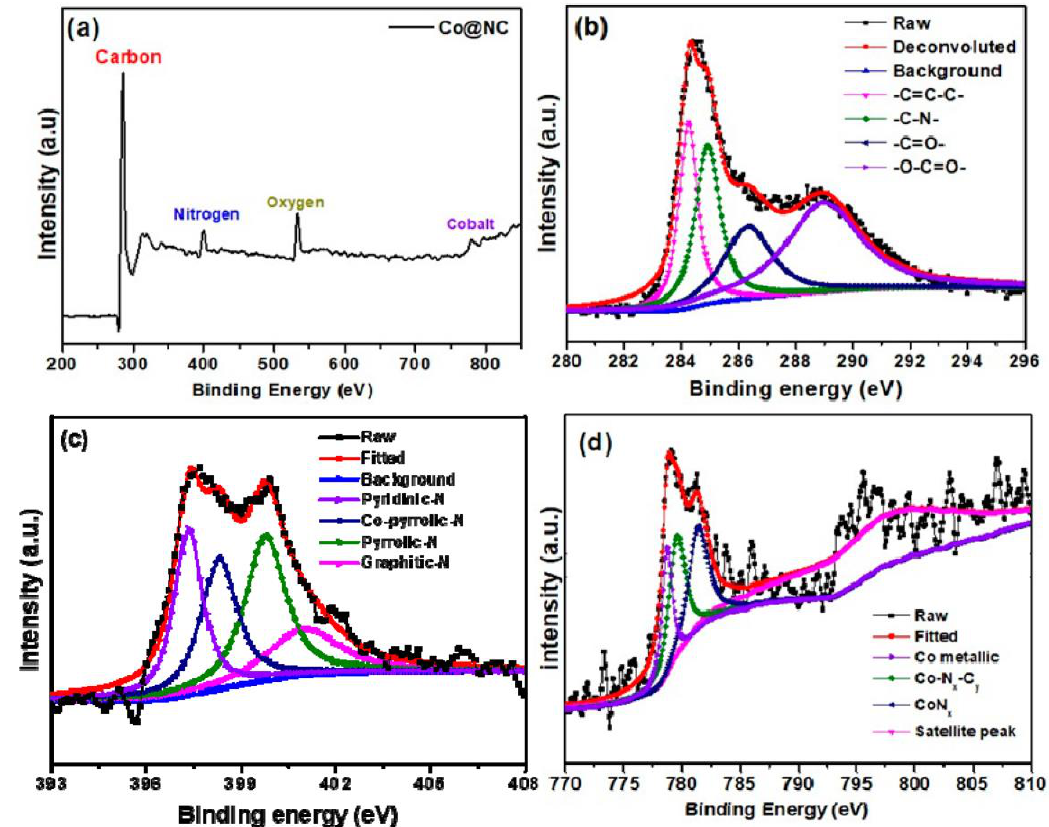
Figure 4. ( a ) X-ray photoelectron spectroscopy (XPS) survey spectra of the Co@NCcatalyst and high-resolution deconvoluted spectra of the ( b ) C1s, ( c ) N1s, and ( d ) Co 2p spectra.